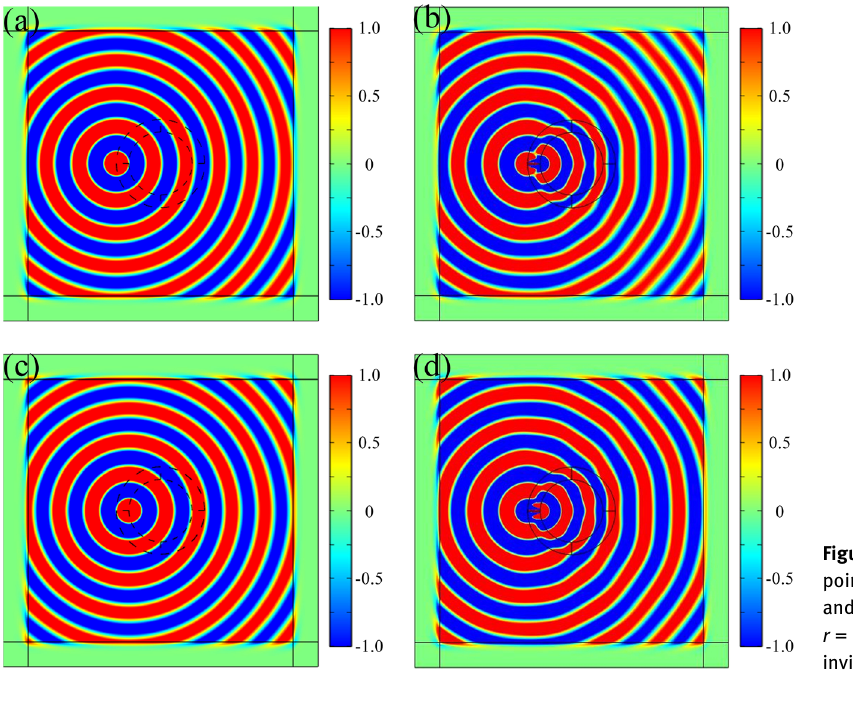
Figure 5: H z component diagram when the pointsourceisplacedat r = R 1 (a)invacuum and(b) α -MoO 3 invisibilityconcentratorand r = R 2 in (c) vacuum and (d) α -MoO 3 invisibility concentrator,